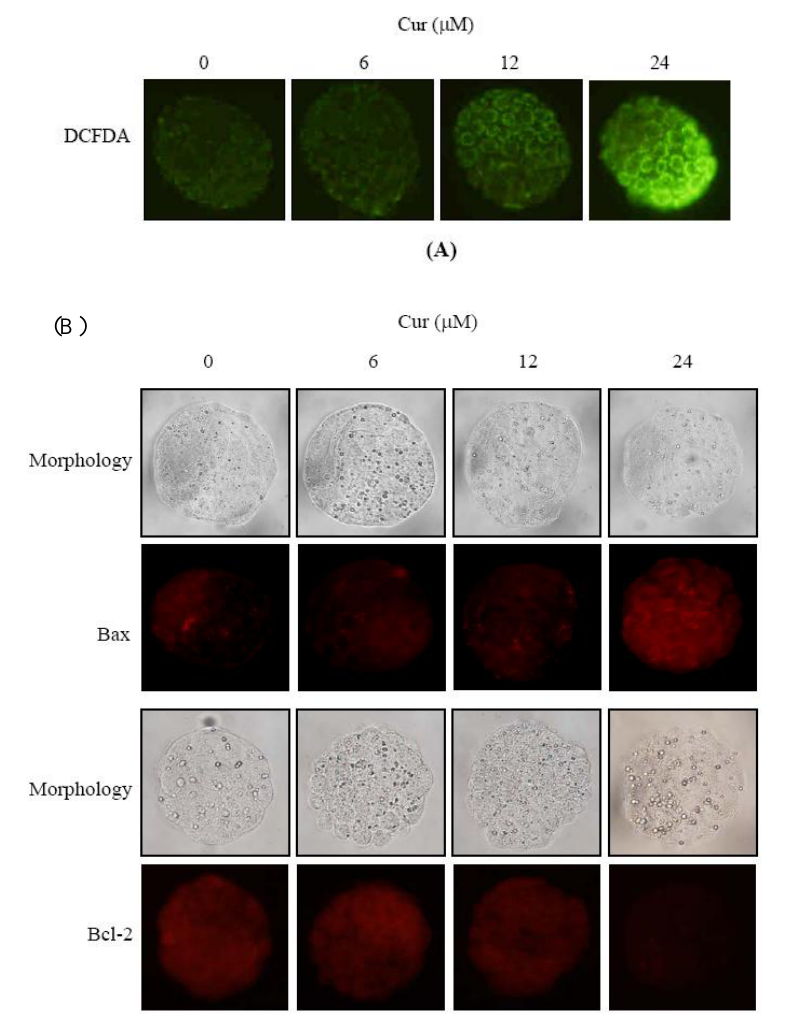
Figure 5. Effects of curcumin on ROS generation and mitochondria-dependent apoptotic processes in mouse blastocysts. Mouse blastocysts were treated with curcumin (Cur, 6, 12 or 24 μM) or left untreated for 24 h. (A) ROS generation was detected by staining with 20 μM DCF-DA fluorescence dye. (B) Bax and Bcl-2 expression levels were determined by immunostaining with anti-Bax and anti-Bcl-2 antibodies, respectively. The protocol is described in “Materials and Methods”. (C) To examine mitochondrial membrane potential changes, embryos were incubated with 40 nM DiOC6(3) at 37 °C for 1 h and analyzed under a fluorescence microscope. (D) Activation of caspase-3 was analyzed by immunostaining with anti-activated caspase-3 antibody for 3 h, followed by a secondary antibody conjugated with peroxidase (1:100) for 1 h. Finally, 20 μL of DAB-substrate solution was added to embryos, and incubated for 2 min at room temperature. Cells with activated caspase-3 are presented in black.